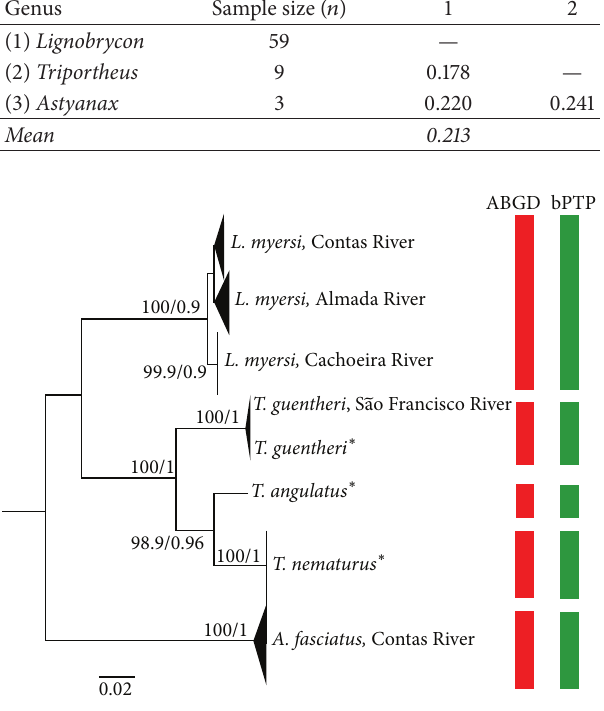
Figure 2: Consensus tree based on NJ and BI analysis of COI sequences in L. myersi from Contas ( 𝑛 = 41 ), Almada ( 𝑛 = 14 ), and Cachoeira ( 𝑛 = 4 ) River basins, Triportheus guentheri ( 𝑛 = 4 ), T. angulatus ( 𝑛 = 1 ), T. nematurus ( 𝑛 = 4 ), and Astyanax fasciatus ( 𝑛 = 3 ). ∗ indicates the sequences obtained in GenBank. The columns on the right indicate the five taxonomic entities (species) recovered by ABGD and bPTP